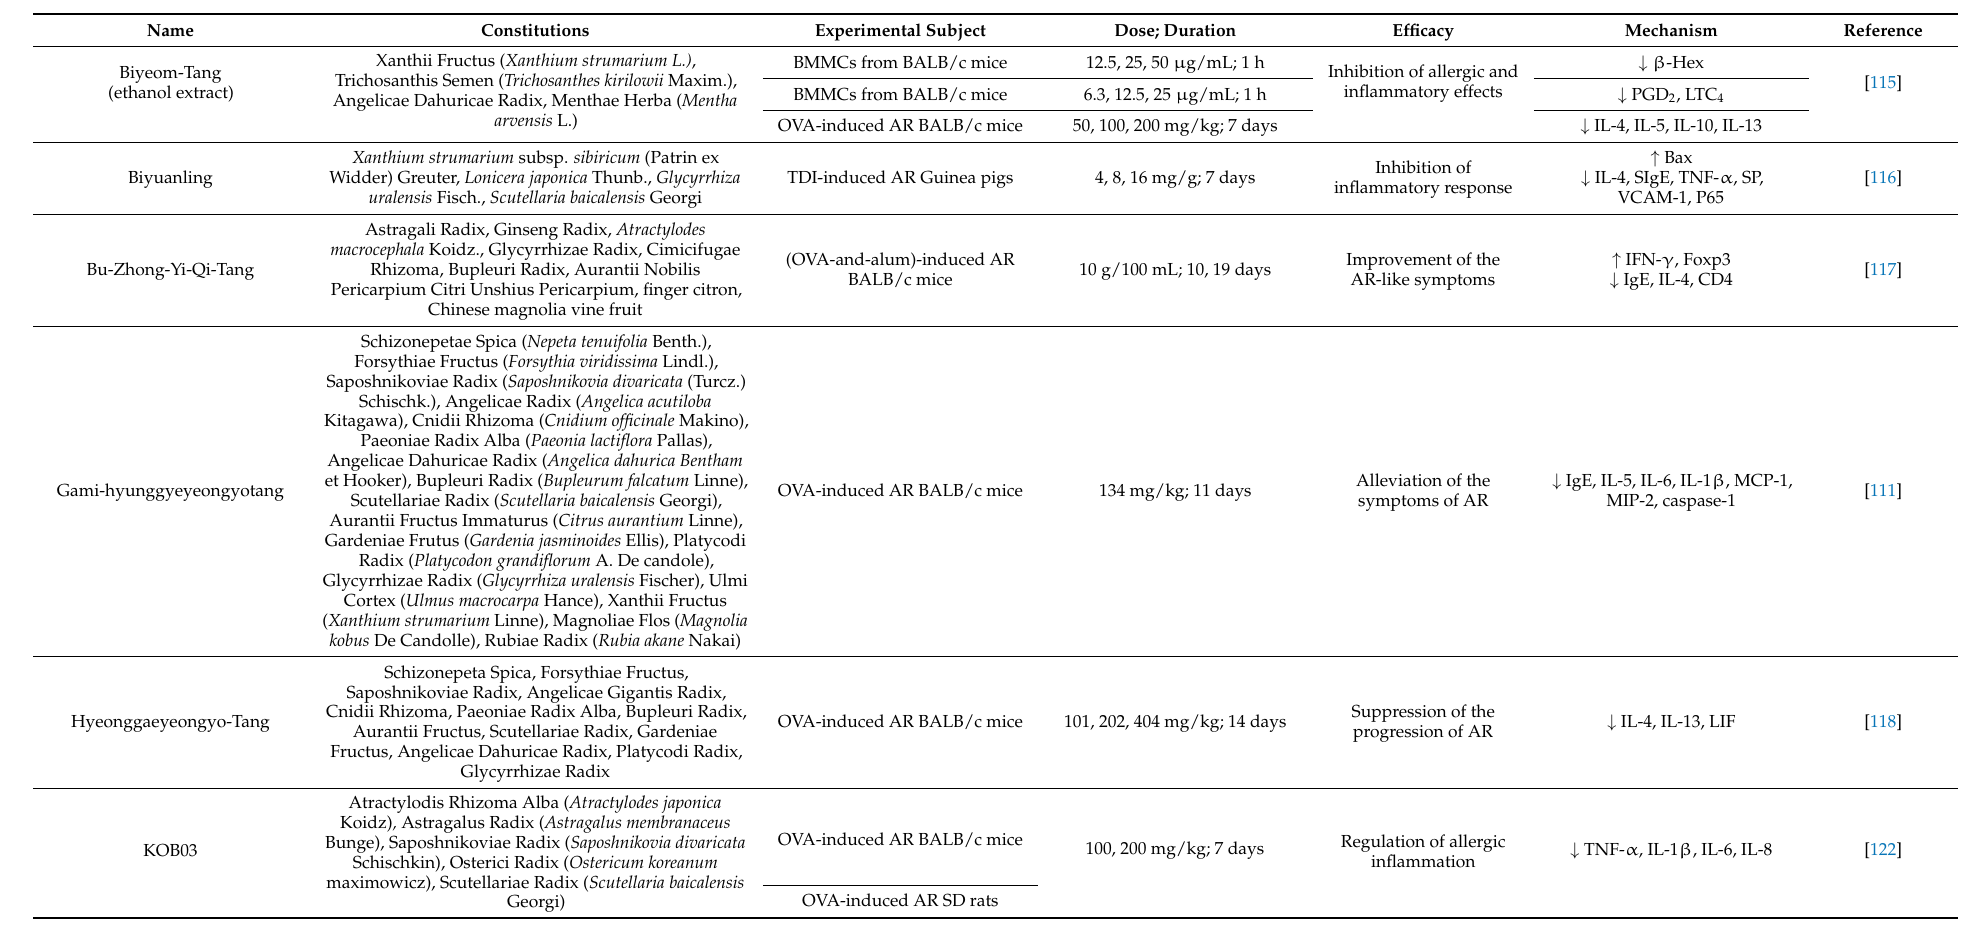
Table 6. In vivo studies—decoctions of natural